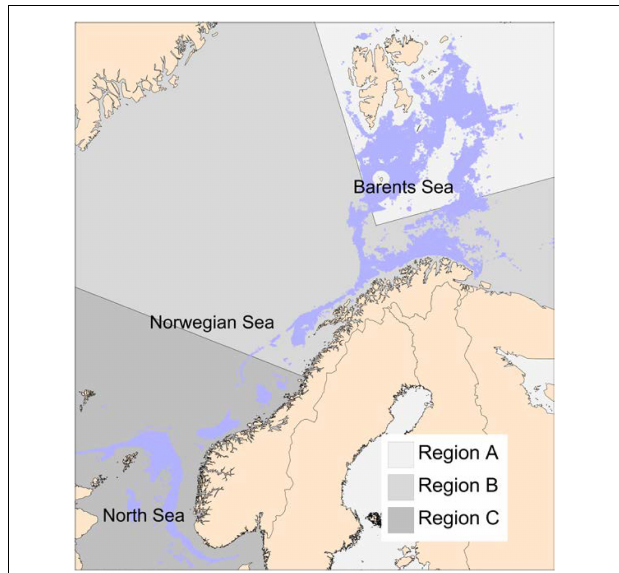
FIGURE 1 | Schematic representation of the spatial distribution of the Norwegian bottom-trawl vessels. Purple dots show the catch locations in the codfish fishery based on the haul-level observations for 53 licensed trawl vessels over the period of 2011–2016. A total of 68,356, 54,145, and 35,397 observations were collected for cod, saithe, and haddock fisheries, respectively. The cod and haddock fisheries are prevalent in regions A and B, while the saithe fishery dominates in region C. The Norwegian Directorate of